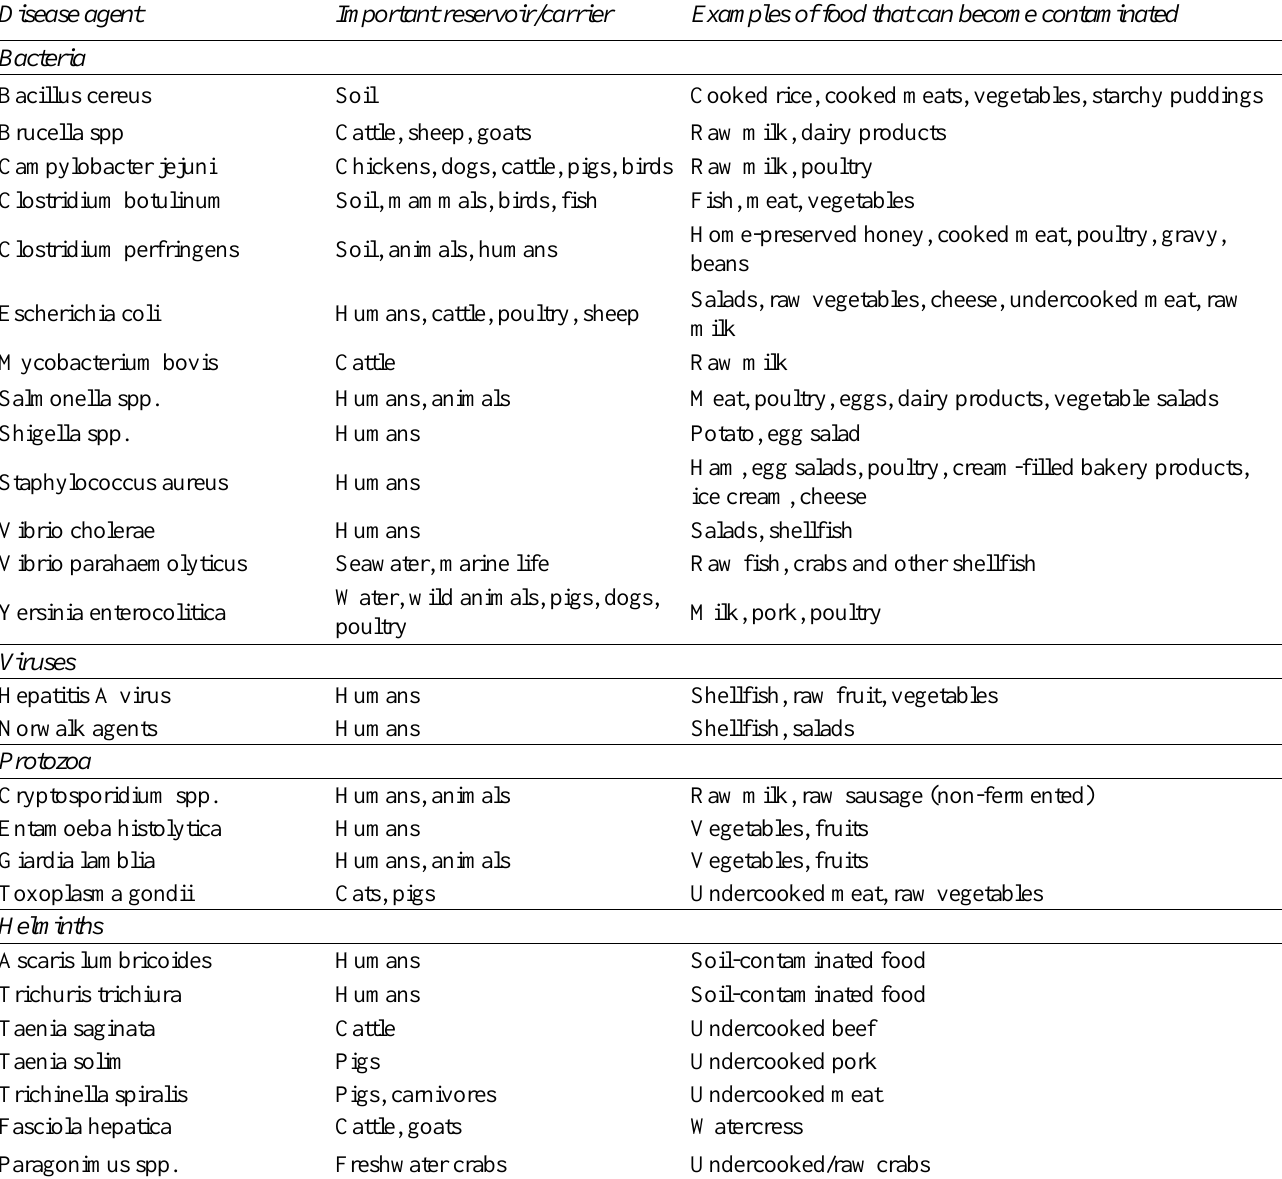
Table 5: Biological agents of important food-borne diseases and main epidemiological features Disease agent Important